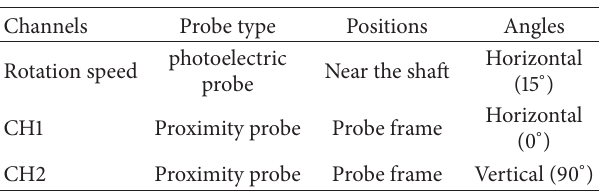
Figure 12: The whole experimental setup.